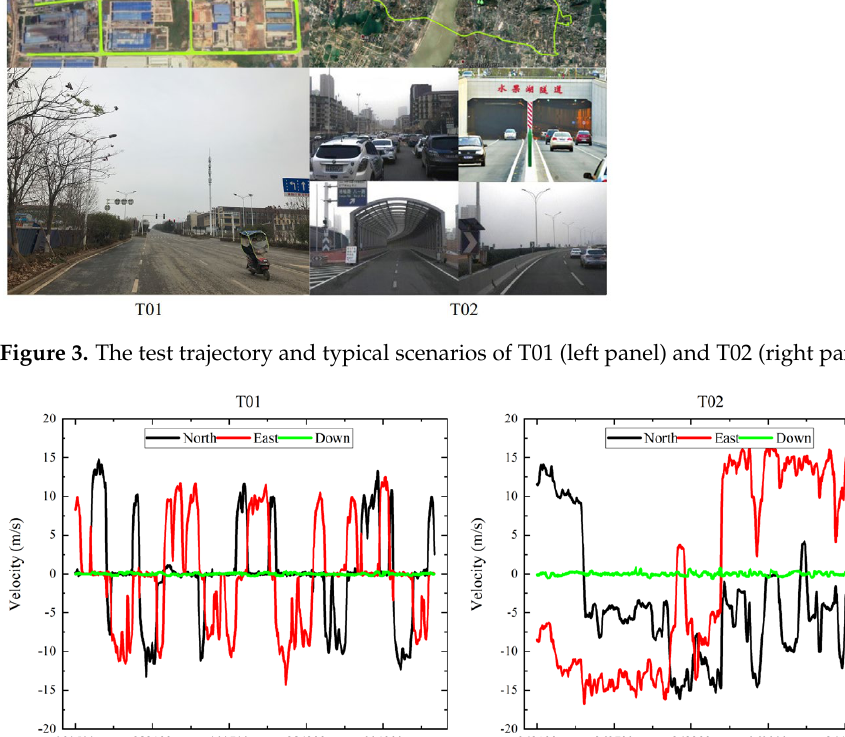
Figure 4. Velocity of the vehicle for T01 (left panel) and T02 (right panel),